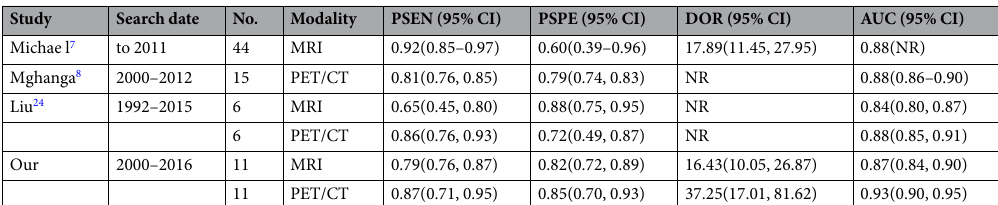
Table 4. Summary of meta-analyses focused on MRI and PET/CT for the assessment of breast cancer response to NAC. PSEN = pooled sensitivities; PSPE = pooled specificities; DOR = diagnostic odds ratio; NR = not